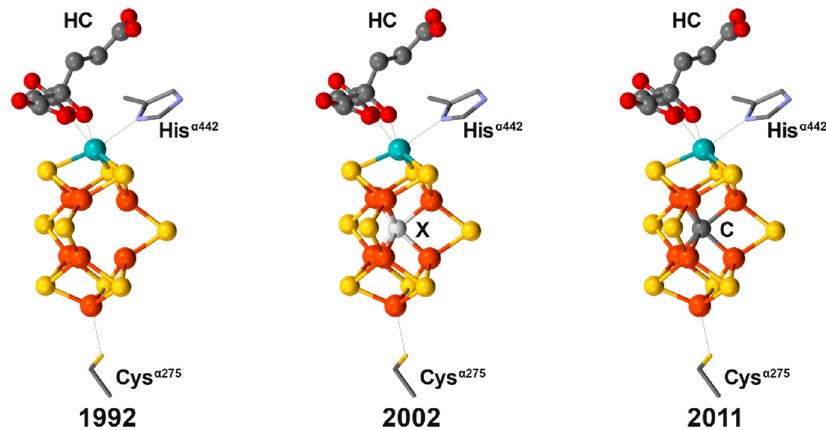
Figure 1. Progression of structure refinement for the iron-molybdenum cofactor (FeMoco) from structural X-ray di ff raction (XRD) data and specialized Electron Paramagnetic Resonance (EPR) and X-ray emission (XES) data [3–8].